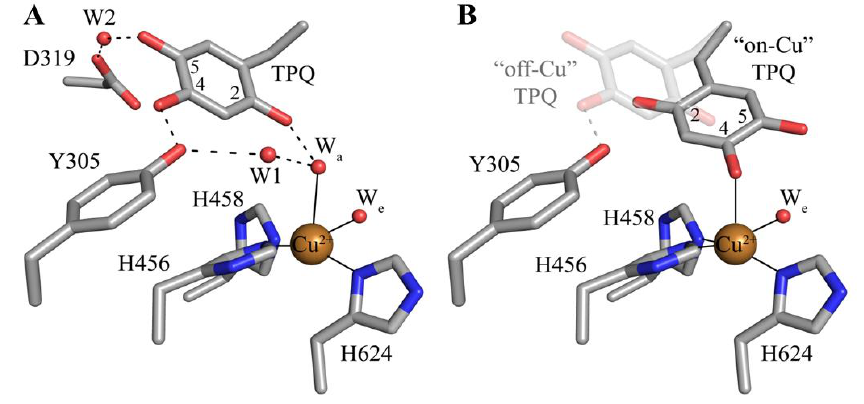
Figure 4. Crystal structures of the HPAO-1 active site (PDB code 2oov) with TPQ in an ( A ) ―off-copper‖ or ( B ) ―on-copper‖ conformation [55,64]. Residues are drawn in stick and colored by atom type (carbon, grey). Copper ions are drawn as gold spheres, and water molecules are drawn as small red spheres. Hydrogen bonds are indicated by dashed lines, and metal-ligand interactions are indicated by solid lines. In ( B ), the ―off-copper‖ TPQ conformer from panel ( A ) is drawn in semi-transparent